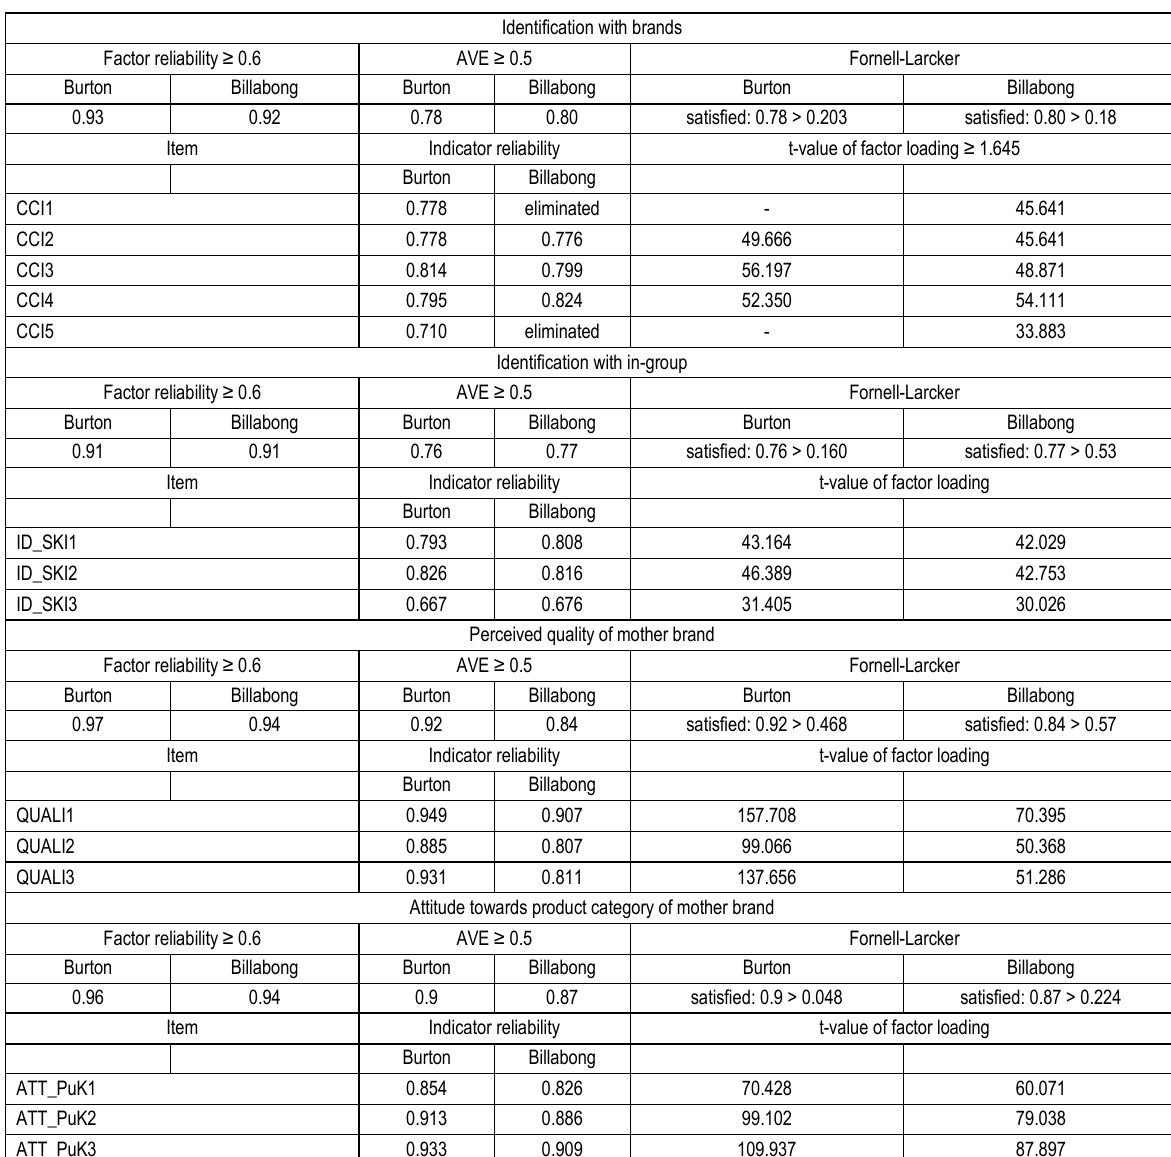
Table 6. Local measures of goodness of the individual